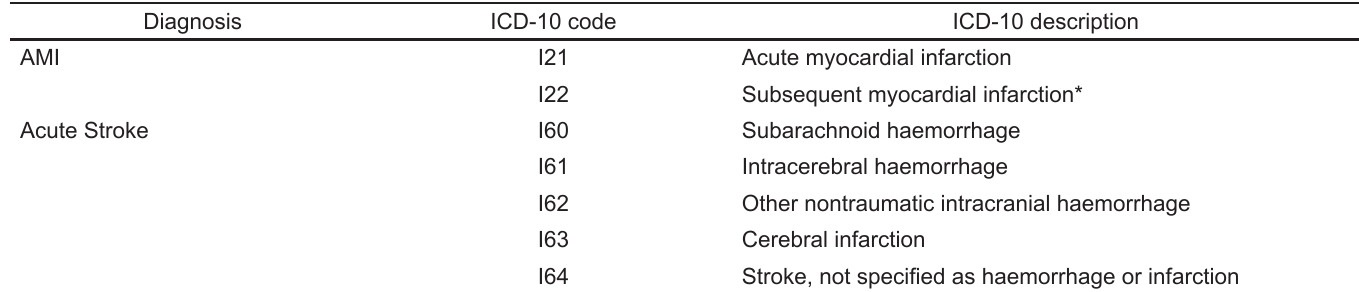
Table 1. International Classification of Diseases codes used to abstract most responsible diagnoses.